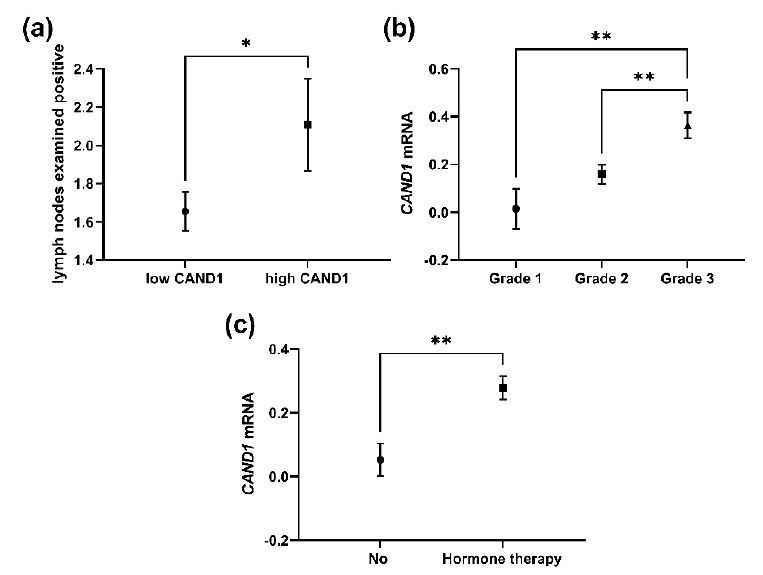
Figure 4. Plots evaluating CAND1 expression in ER α -positive breast cancer patients according to different clinical parameters: ( a ) Analysis for lymph nodes examined positive; ( b ) analysis for neoplasm histologic grades; ( c ) analysis for ER α -positive breast cancer patients who received hormone therapy and patients who did not receive hormone therapy. * p < 0.05 and ** p < 0.01.